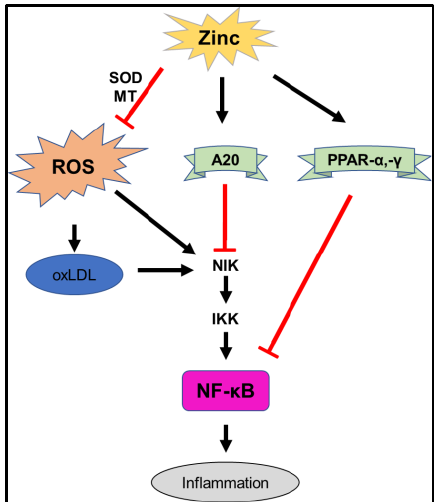
Figure 3. Mechanism of inflammation inhibited by zinc. Schematic diagram of zinc-mediated suppression of inflammatory pathways. Arrows indicate activation or signaling, and red lines indicate inhibition. MTs, whose expression is upregulated by zinc, suppress ROS production. Since ROS and NIK both activate NF-κB, zinc suppresses inflammation by inhibiting NF-κB-mediated pathways and plays a role in suppressing inflammation by inhibiting the NF-κB-mediated pathway. NIK: NF-κB-inducing kinase. IKK: Inhibitor of κB kinase. PPAR: Peroxisome Proliferator-Activated Receptor.